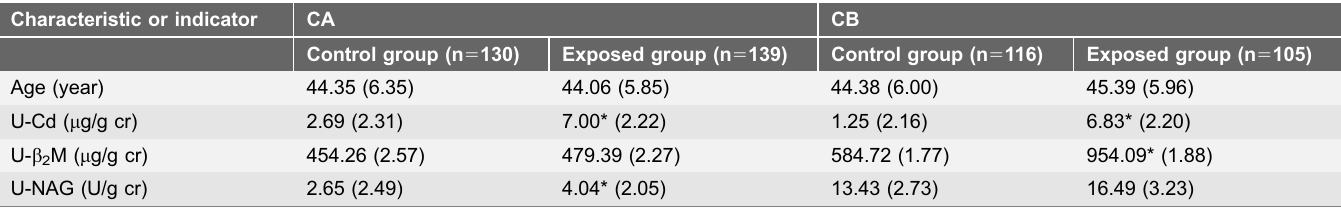
g Values of U-Cd, U- b 2 M, and U-NAG are expressed as GM and GSD, and values of age were calculated by arithmetic mean and SD. *Compared with the control group, P ,